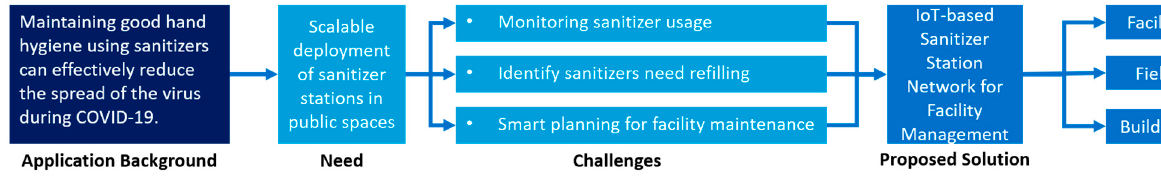
Figure 1. Motivation for the proposed approach.